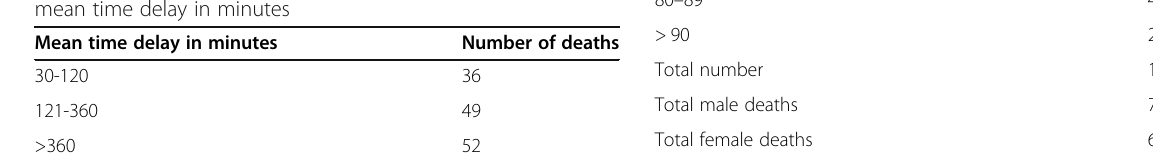
Table 6 It shows the number of death and the